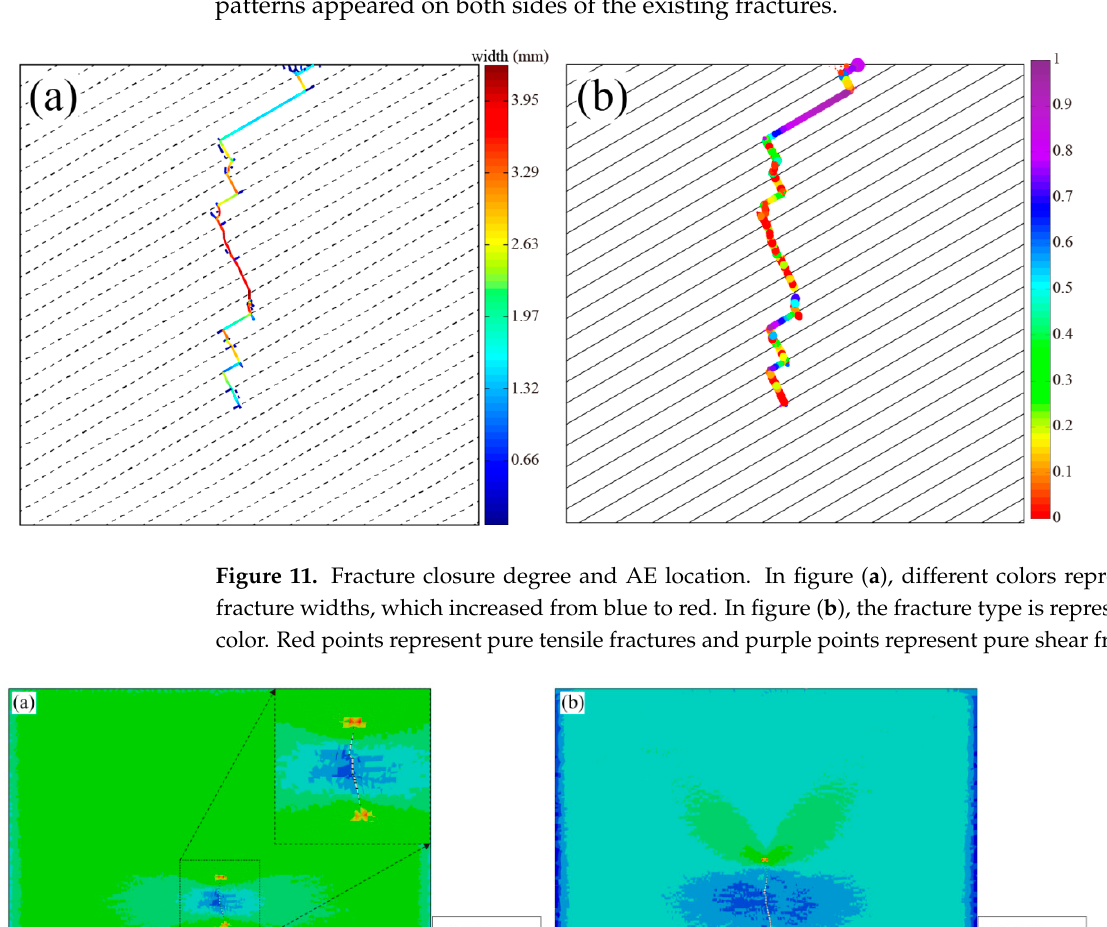
Figure 11. Fracture closure degree and AE location. In figure ( a ), different colors represent the frac- ture widths, which increased from blue to red. In figure ( b ), the fracture type is represented by color. Red points represent pure tensile fractures and purple points represent pure shear fractures.